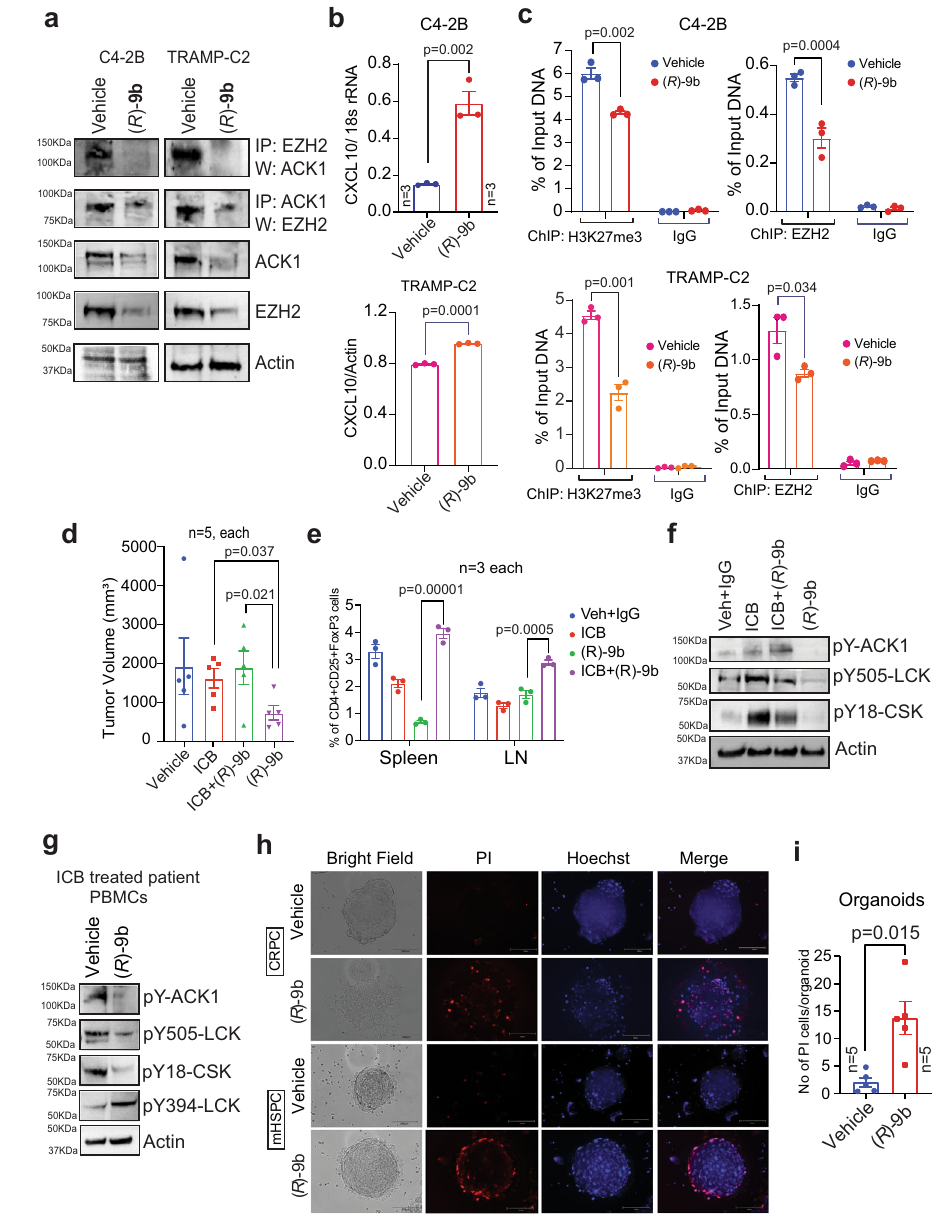
α CTLA-4antibodies(ICB),oritscombinationwith( R )- 9b ( n =5miceineachgroup). e Splenocytes were isolated and lymph nodes were drained to assess the Treg (CD4 + CD25 + FoxP3 + ) population ( n =3 mice in each group). f Representative immunoblots of spleen lysates from mice described above are shown ( n =3 bio- logically independent experiments). g PBMCs were isolated from blood of ICB treated mHSPC patient. The PBMCs were treated with ( R )- 9b for 6h and immu- noblotting was performed with the indicated antibodies. h The PBMCs from prostatecancerpatientsweretreatedwithvehicleor( R )- 9b for6h,washedandco- cultured with prostate cancer organoids. After 24h, the organoids were stained with PI and Hoechst 33258 and observed under fl uorescent microscope. Repre- sentative images are as shown ( n =3 biologically independent experiments). i Quantitation of the data shown in h . For b – e and i the data are represented as mean±SEM and p values were determined by unpaired two-tailed Student ’ s t -test. Source data are provided as a Source Data fi